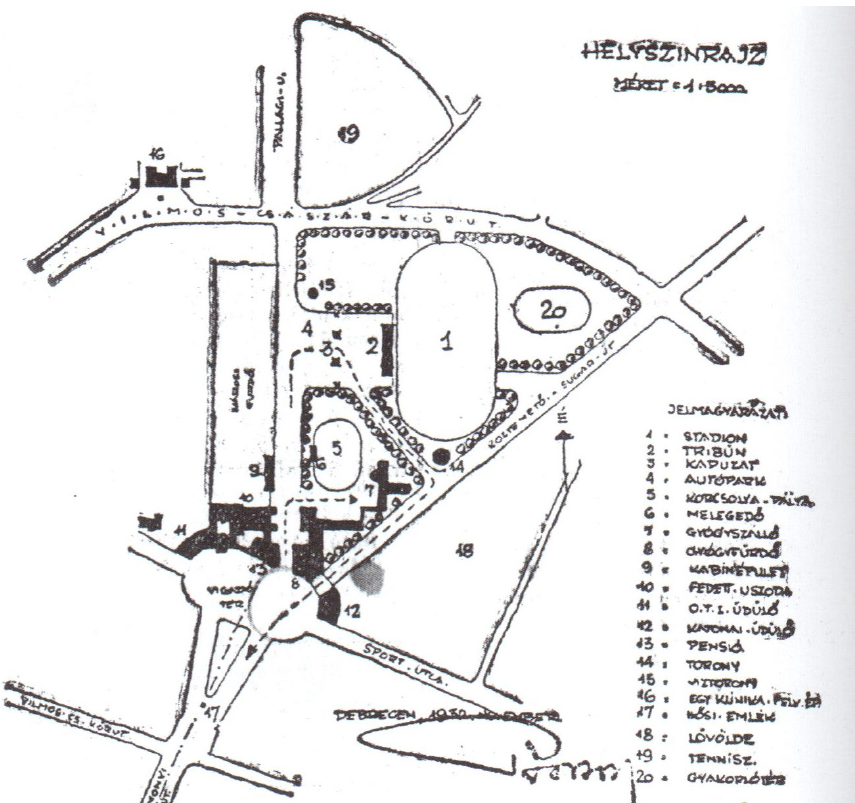
Figure 3. Development plan of Great Forest drawn up by József Boros in 1930 Source: [33] p. 144.